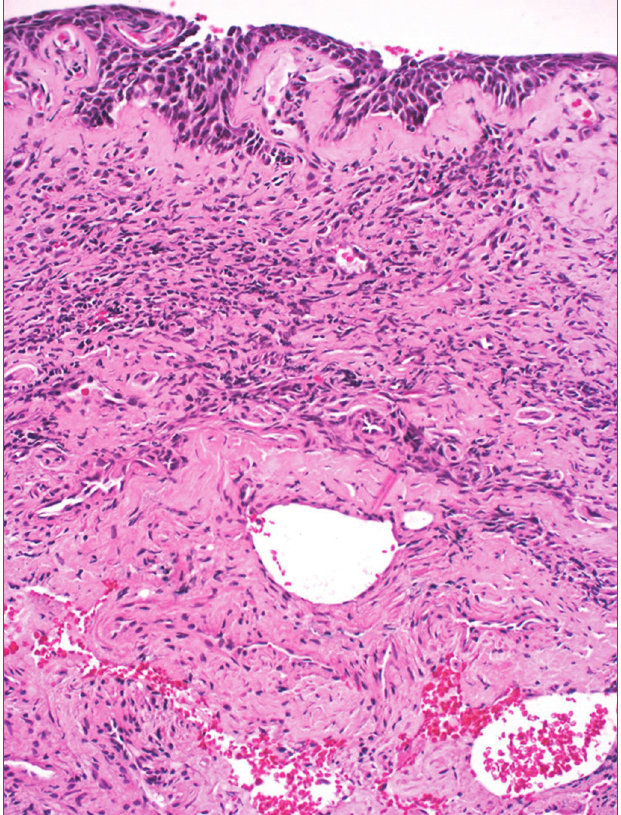
Figura 4. Rinite crônica severa Lâmina com aumento de 400X e colo- ração por Hematoxilina Eosina - lâmina evidencia infiltrado inflamatório intenso (área rósea mais densa) com áreas hemorrágicas